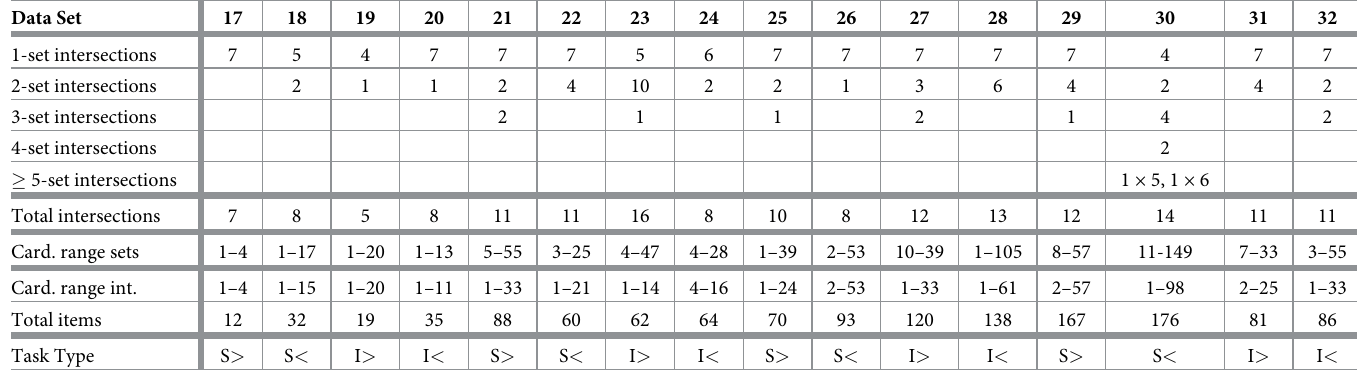
Table 2. Complexity of seven-sets